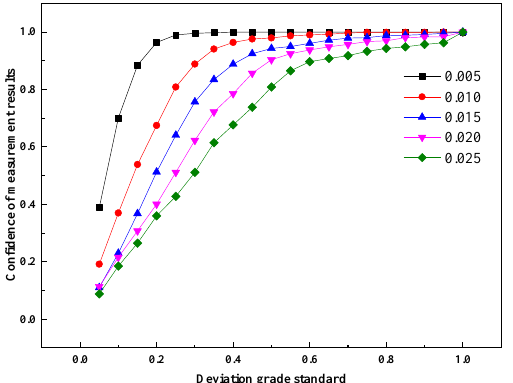
Figure 11. Relationship between deviation grade standard and confidence of measurement results under the different relative standard deviations of temperature at mean temperature 563 K.